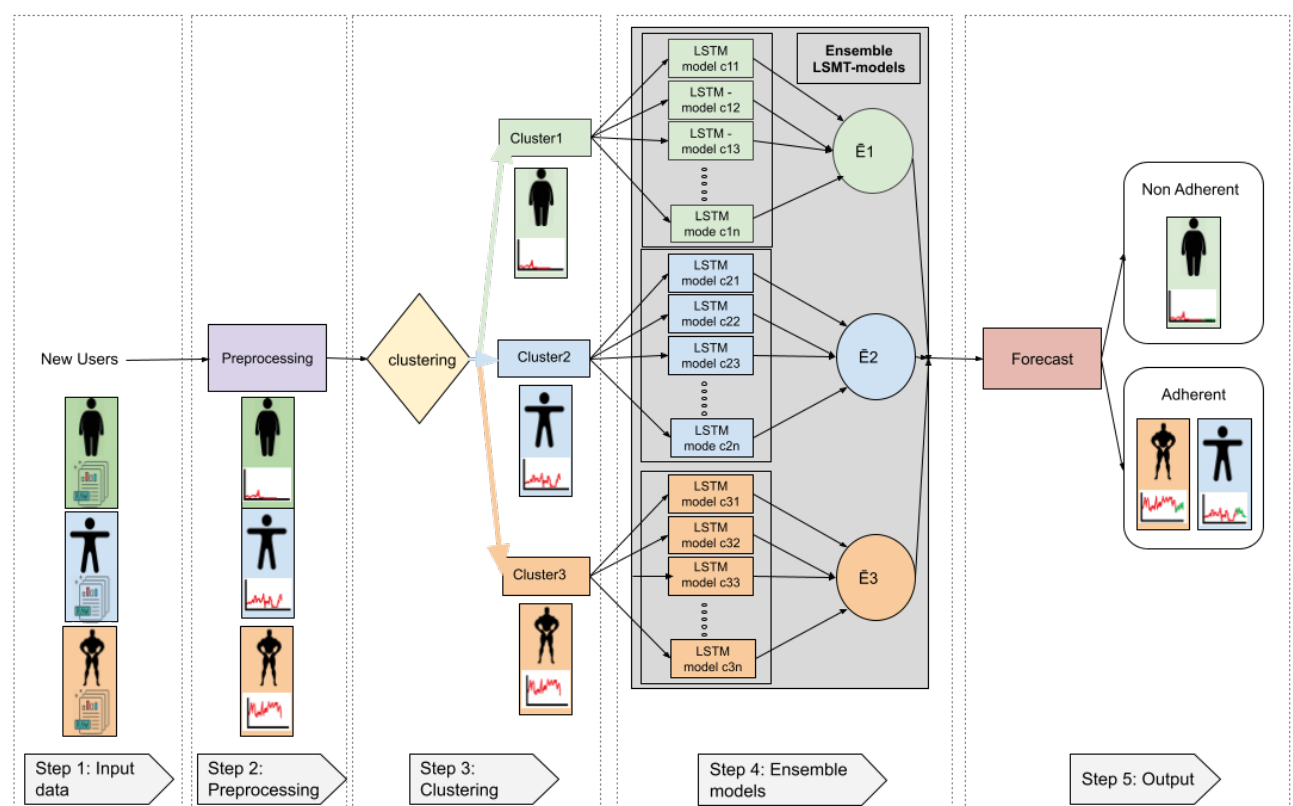
Figure 6. Example of the proposed system with three different user categories.